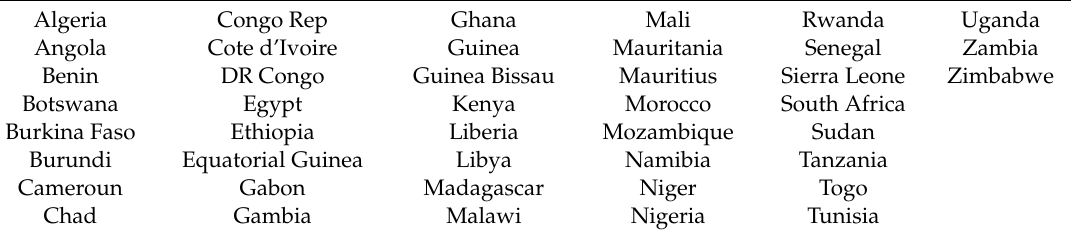
Table A1. List of 43 African countries in the study